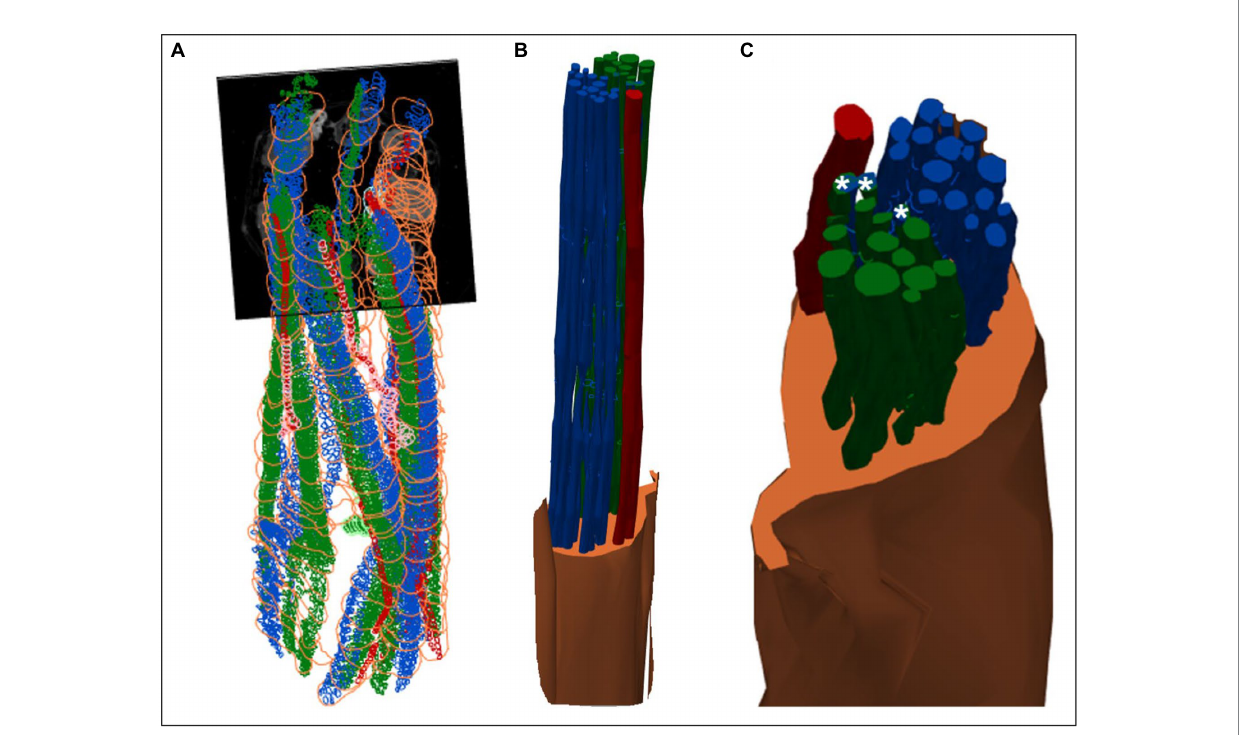
FIGURE 8 3D shelled segmentation of fascicles in the nerve. (A) An example of the segmentation of the fascicles in the nerve within a stitched scan (all four scans stitched together) with contours placed every 50 to 100 sections throughout the length of the six segments of nerve. (B) The contours can be joined together by 3D shelling data of a certain label (i.e., cardiac or pulmonary or vagus nerve). Recurrent laryngeal is shown in green, pulmonary in blue, cardiac in red and the vagus trunk in orange. (C) A closer view of the segmented vagus nerve for visualization of the distribution of fascicle types within the vagus nerve at the cervical level. Merged fascicles containing both pulmonary and recurrent laryngeal fibers are marked with an asterisk. These figures were captured in a 3D environment. For scale bars in 2D, please see Figure